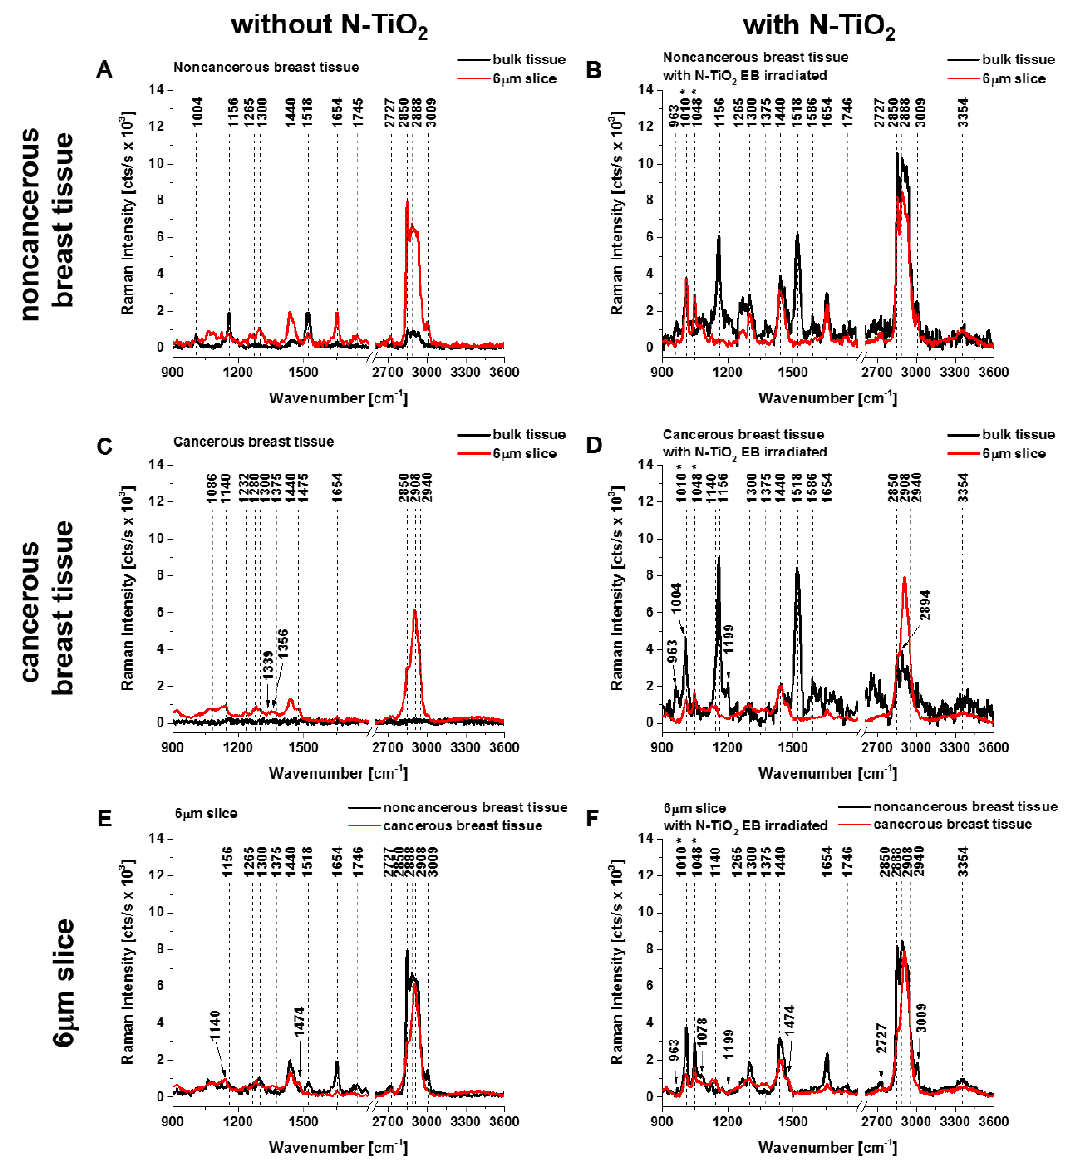
Figure 4. Comparison of Raman spectra for bulk tissues ( A – D ) and 6 µ m slices ( E , F ) of infiltrating ductal carcinoma with ( B , D , F ) and without ( A , C , E ) addition of N-doped TiO 2 (N:Ti = 1:1) nanoparticles electron beam-irradiated with a dose of 500 kGy. Raman spectra are presented after background subtraction. Raman bands attributed to N-doped TiO 2 EB-irradiated NPs are marked with an asterisk